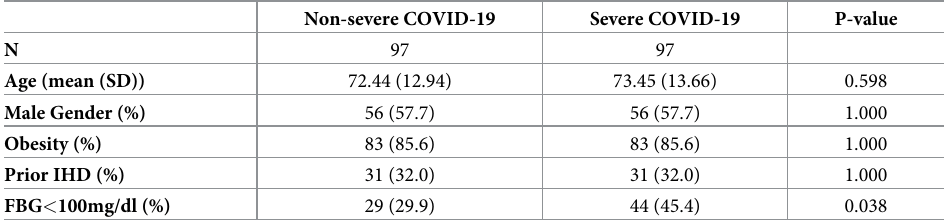
Table 4. Characteristics of diabetic patients in the matched case-control analysis, by severity of COVID-19.